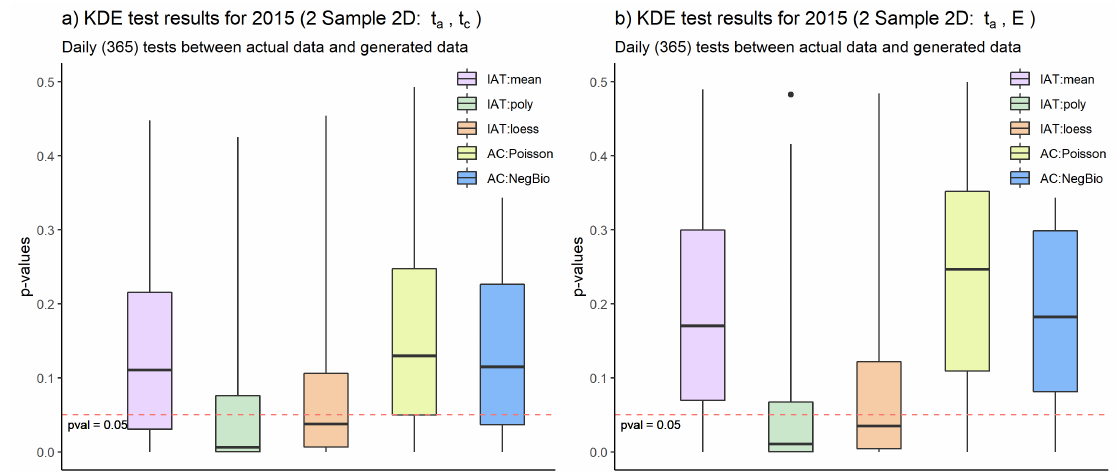
Figure 10. KDE test p-values: Daily 2 sample 2 dimensional KDE tests to compare real-world and generated data. Total of 365 tests performed for each model. p -value > 0.05 means datasets are similar. ( a ) Results for (arrival times t a , connection times t c ). ( b ) Results for (arrival times t a , energy required E